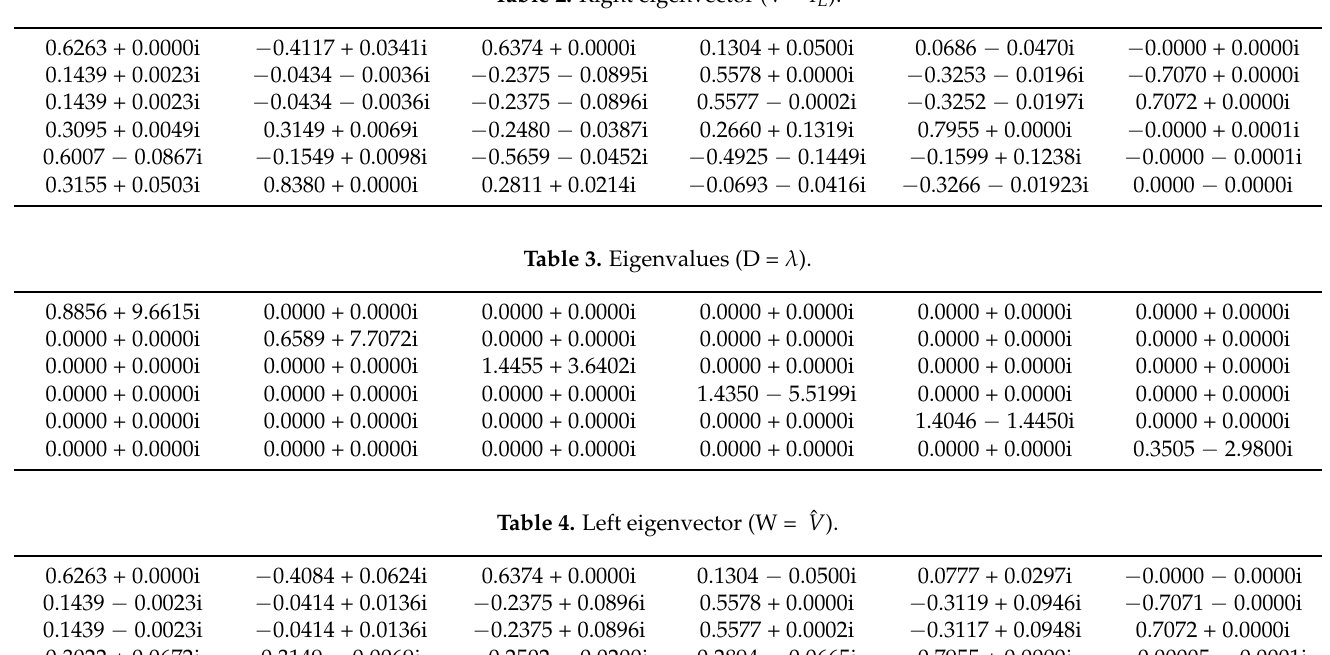
Table 2. Right eigenvector (V = ˆ I L ).